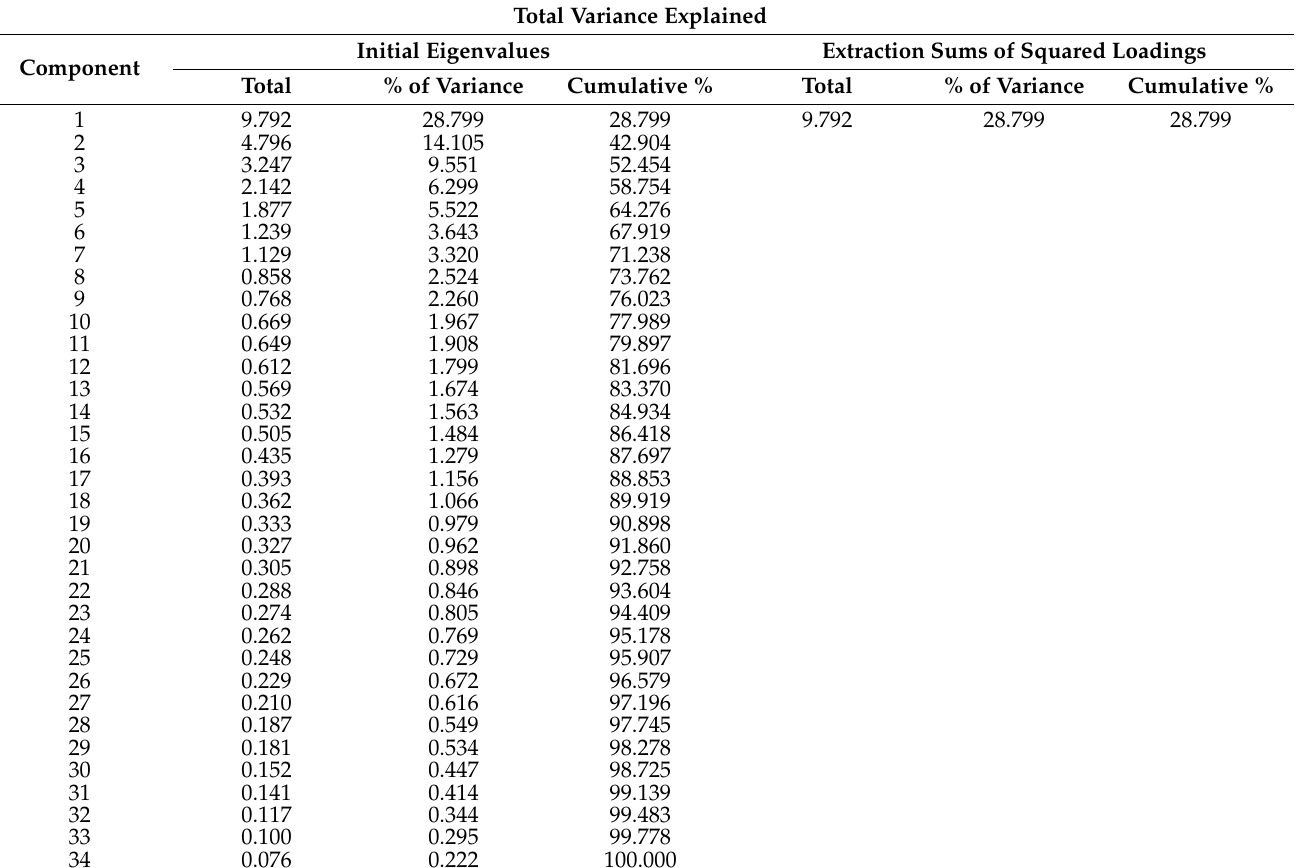
Table 2. Method bias